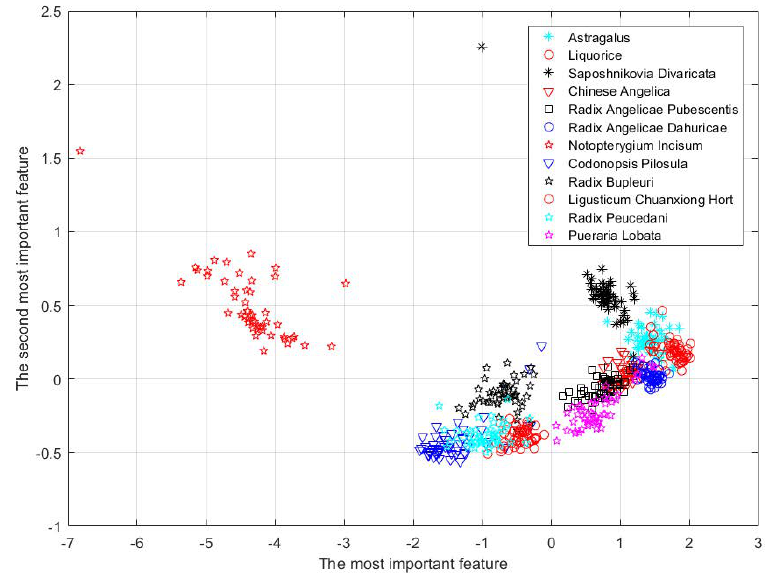
Figure 6. Distribution of samples after